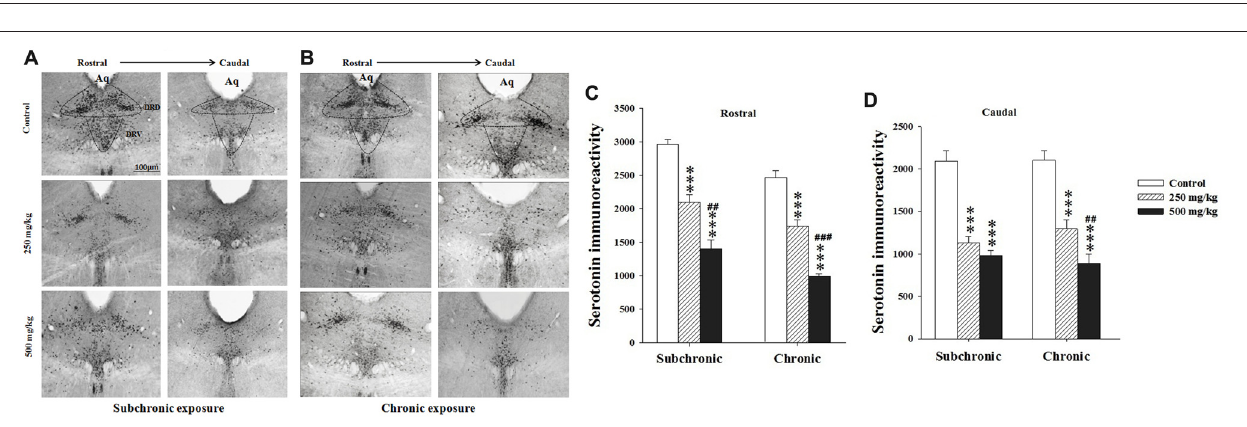
FIGURE 6 | Effect of subchronic and chronic exposure to GBH on serotoninergic neurons. (A) Photomicrographs of mice brain cross sections showing the serotonin (5-HT)-immunoreactive neurons across the rostral to the caudal extent of the dorsal raphe nucleus (DRN) after subchronic exposure. (B) The intensity of 5-HT immunoreactivity at the DRN in control and treated mice following chronic exposure. (C,D) The intensity of 5-HT immunoreactivity at the DRN in control and treated mice. Aq, Cerebral aqueduct. DRD, dorsal raphe dorsal (dorsomedial), DRV, dorsal raphe ventral (ventromedial). Results are presented as mean ± SEM. ∗∗∗ P < 0.001. The ∗∗∗ refers to the control vs. 250 mg/kg and 500 mg/kg group comparison and the “#” refers to the 250 mg/kg vs. 500 mg/kg group comparison. ## P < 0.01, ### P < 0.001: the post hoc